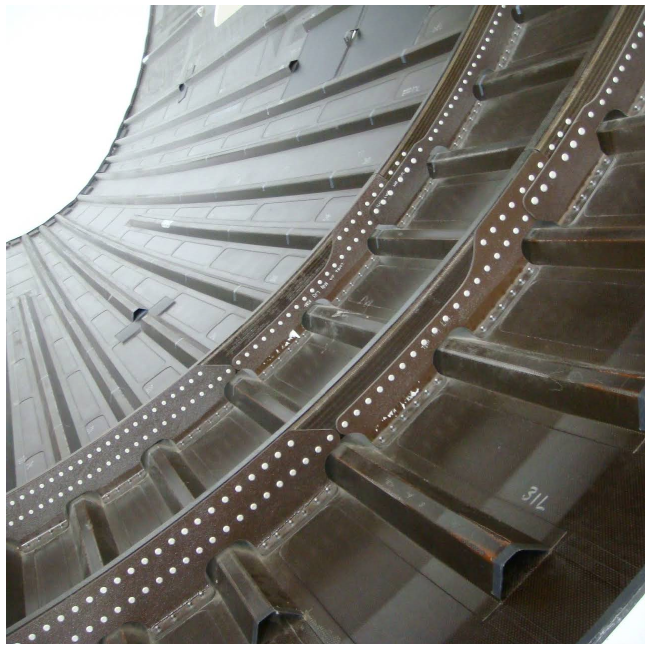
Figure 1. Curved panel with unconventional stringers (Boeing